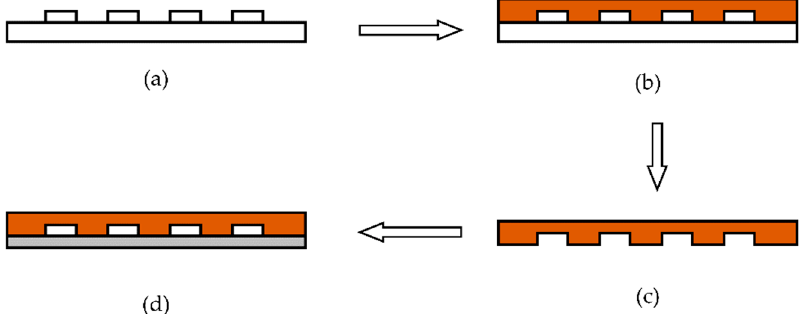
Figure 10. Fabrication of the PDMS microfluidic chip by the pouring process. ( a ) Surface modification on positive die. ( b ) Pouring PDMS without bubbles on to the positive die. ( c ) Curing and separation.